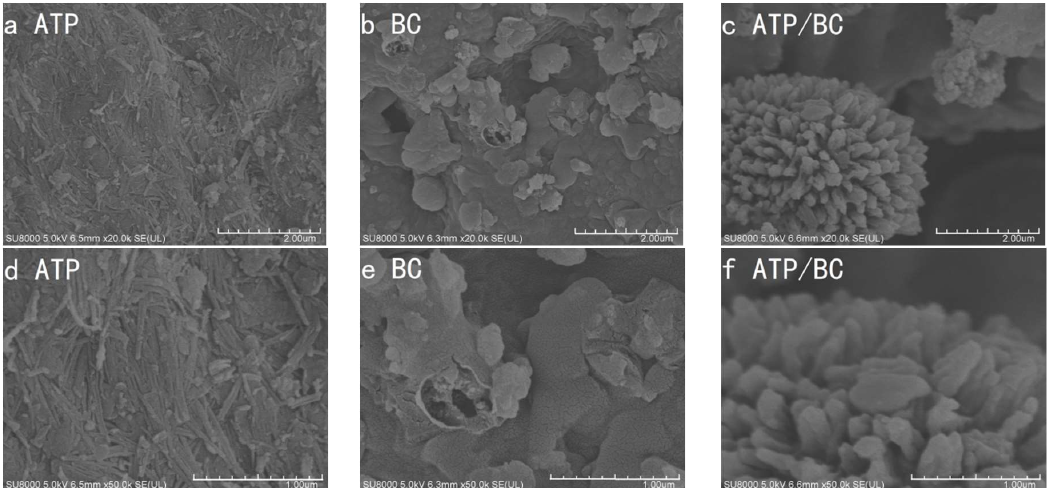
Figure 1. Scanning electron microscope images of ATP ( a , d ), BC ( b , e ), and ATP/BC ( c , f ). The BET method was measured using the specific surface area and pore width of the adsorbents (BC, ATP, ATP/BC-0.01, ATP/BC-0.1, ATP/BC-0.3, and ATP/BC-0.5). In addi- tion, the BET adsorption–desorption isotherm and pore size distribution data are available